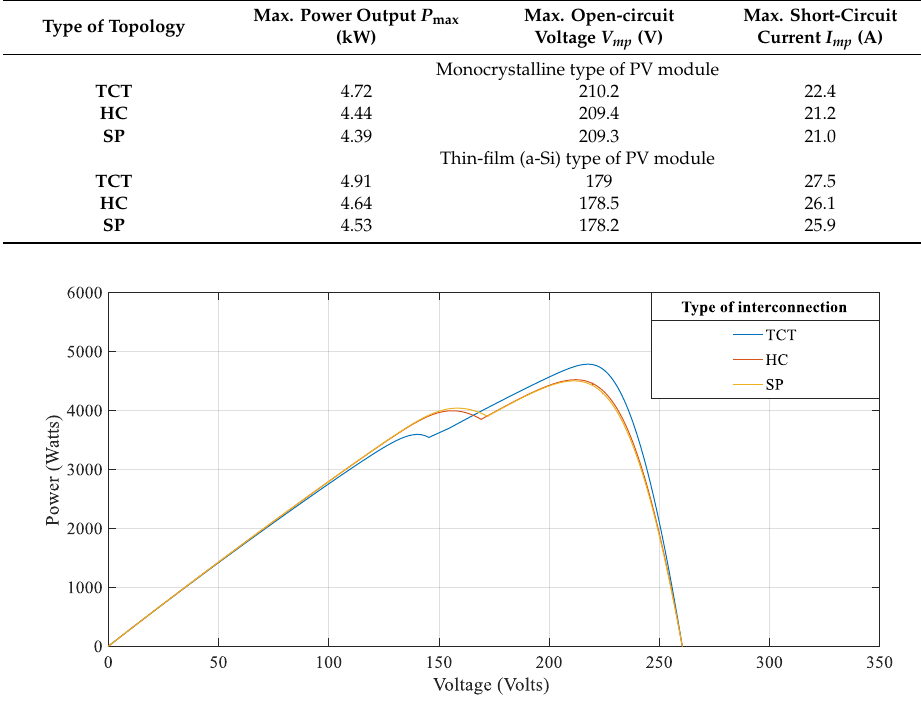
Figure 7. P-V curve for open-circuit fault ‘F1′ (monocrystalline PV).